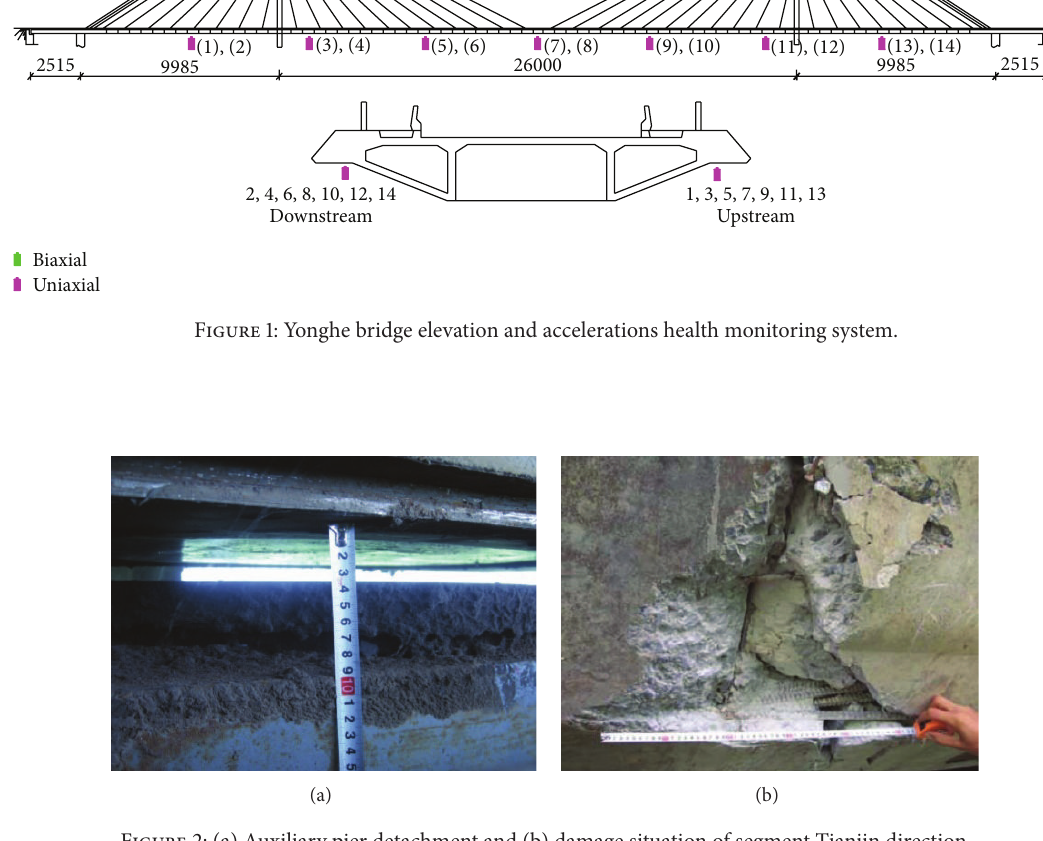
Figure 2: (a) Auxiliary pier detachment and (b) damage situation of segment Tianjin